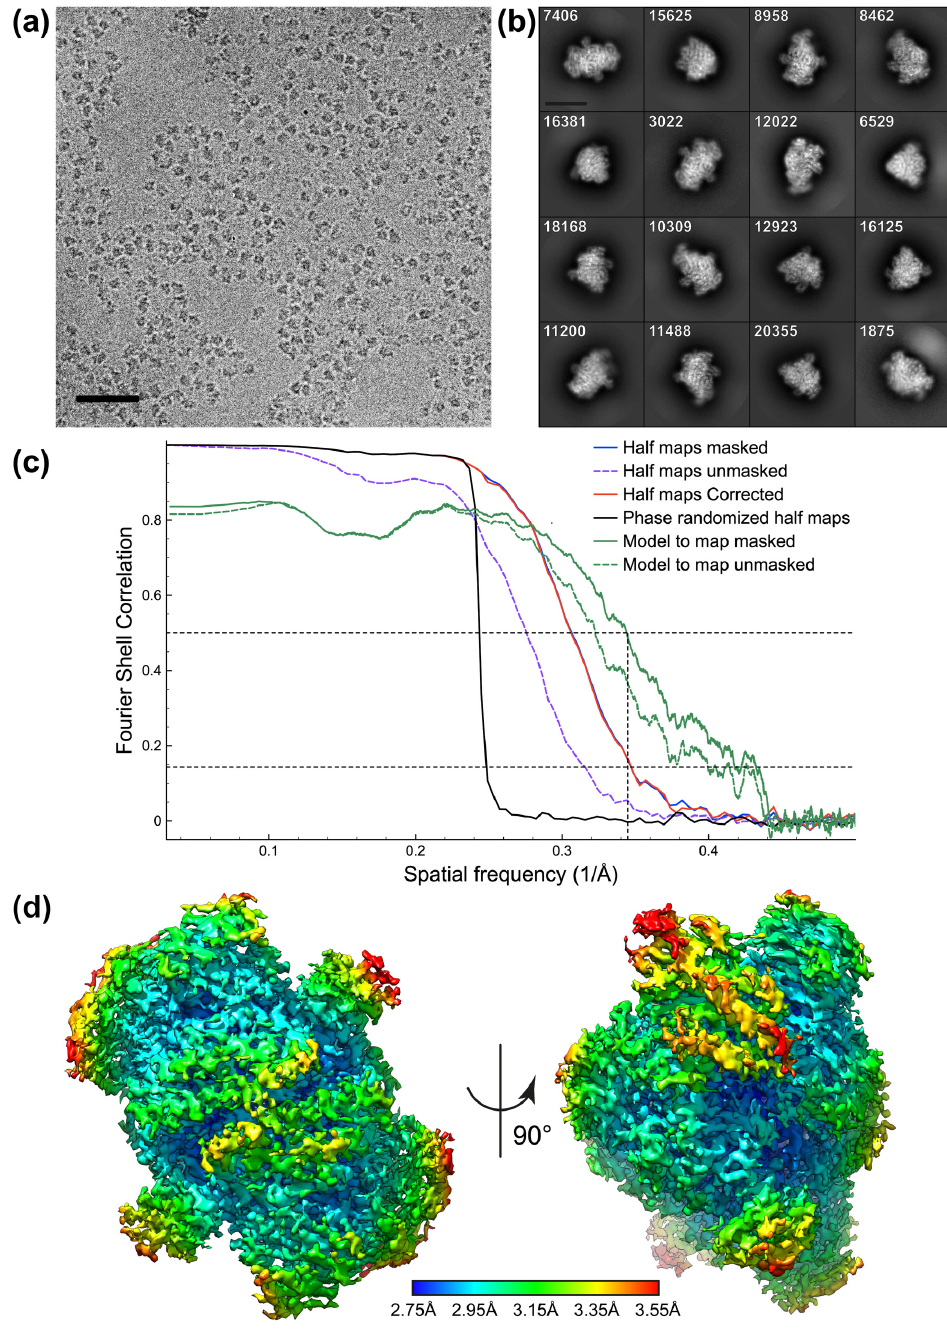
Figure 4. ( a ) Example of a PFOR collected micrograph (scale bar: 50 nm). ( b ) 2D classification of the selected PFOR particles (scale bar: 100 Å). Number of the particles in each 2D class are indicated. ( c ) PFOR Fourier-shell-correlation plots for independently refined half-maps (masked and unmasked, blue; corrected, red), phases randomized half maps (black) and full map versus model (Map to model, green). Horizontal black dashed lines indicate Fourier-shell-correlation values of 0.5 and 0.143. The vertical black dashed line indicates the 2.90 Å resolution. ( d ) Final PFOR reconstruction colored according to the local resolution: from dark blue (2.75 Å) to red (3.55 Å), contoured at 2.7 σ . A cross section of this reconstruction is presented in Figure S5.